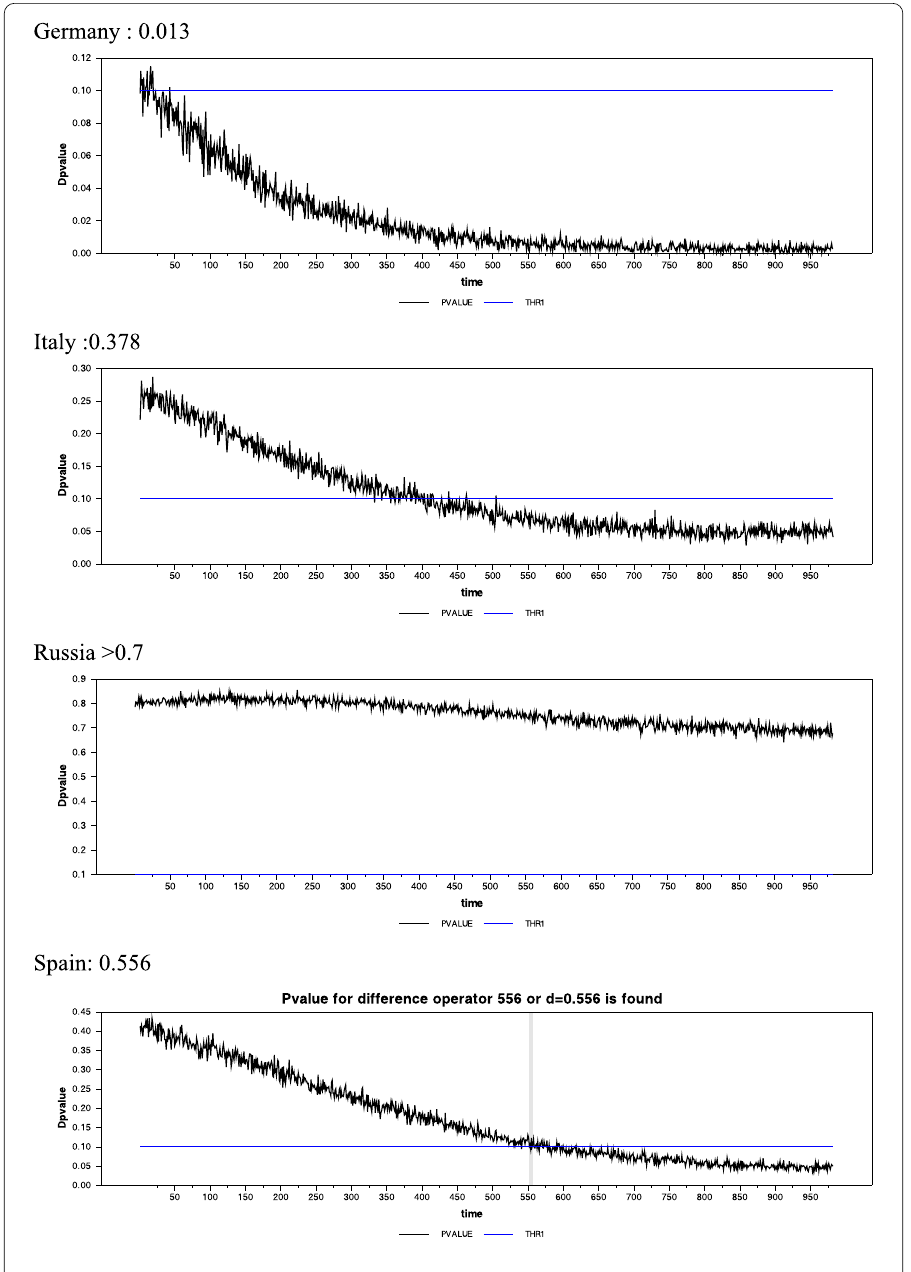
Figure 4 Graphical representation of the new difference estimator for unit-root test